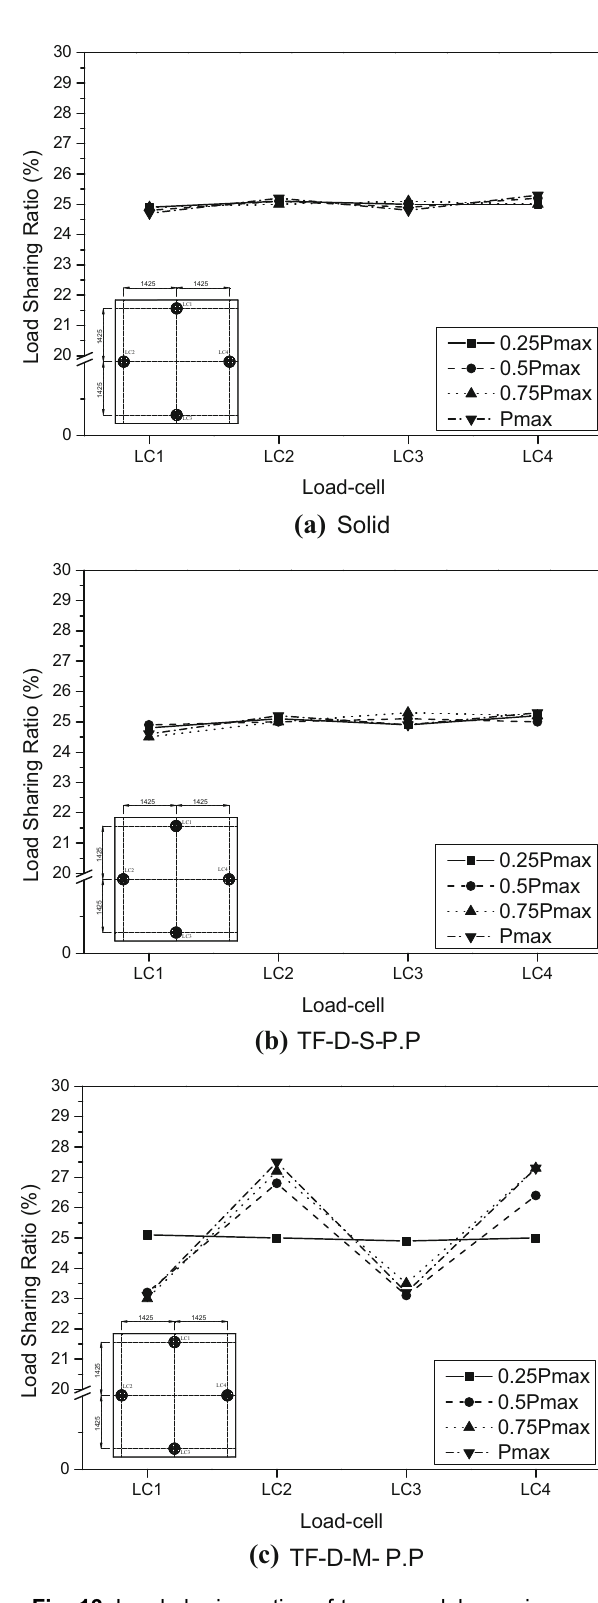
Fig. 13 Load sharing ratios of two-way slab